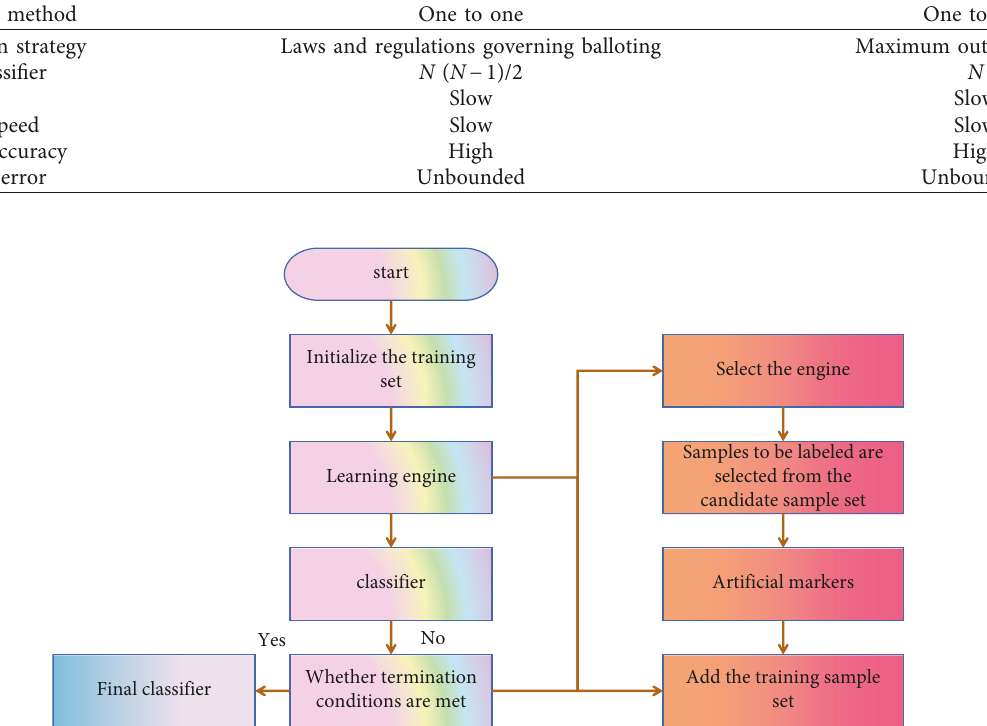
Figure 8: Schematic diagram of active